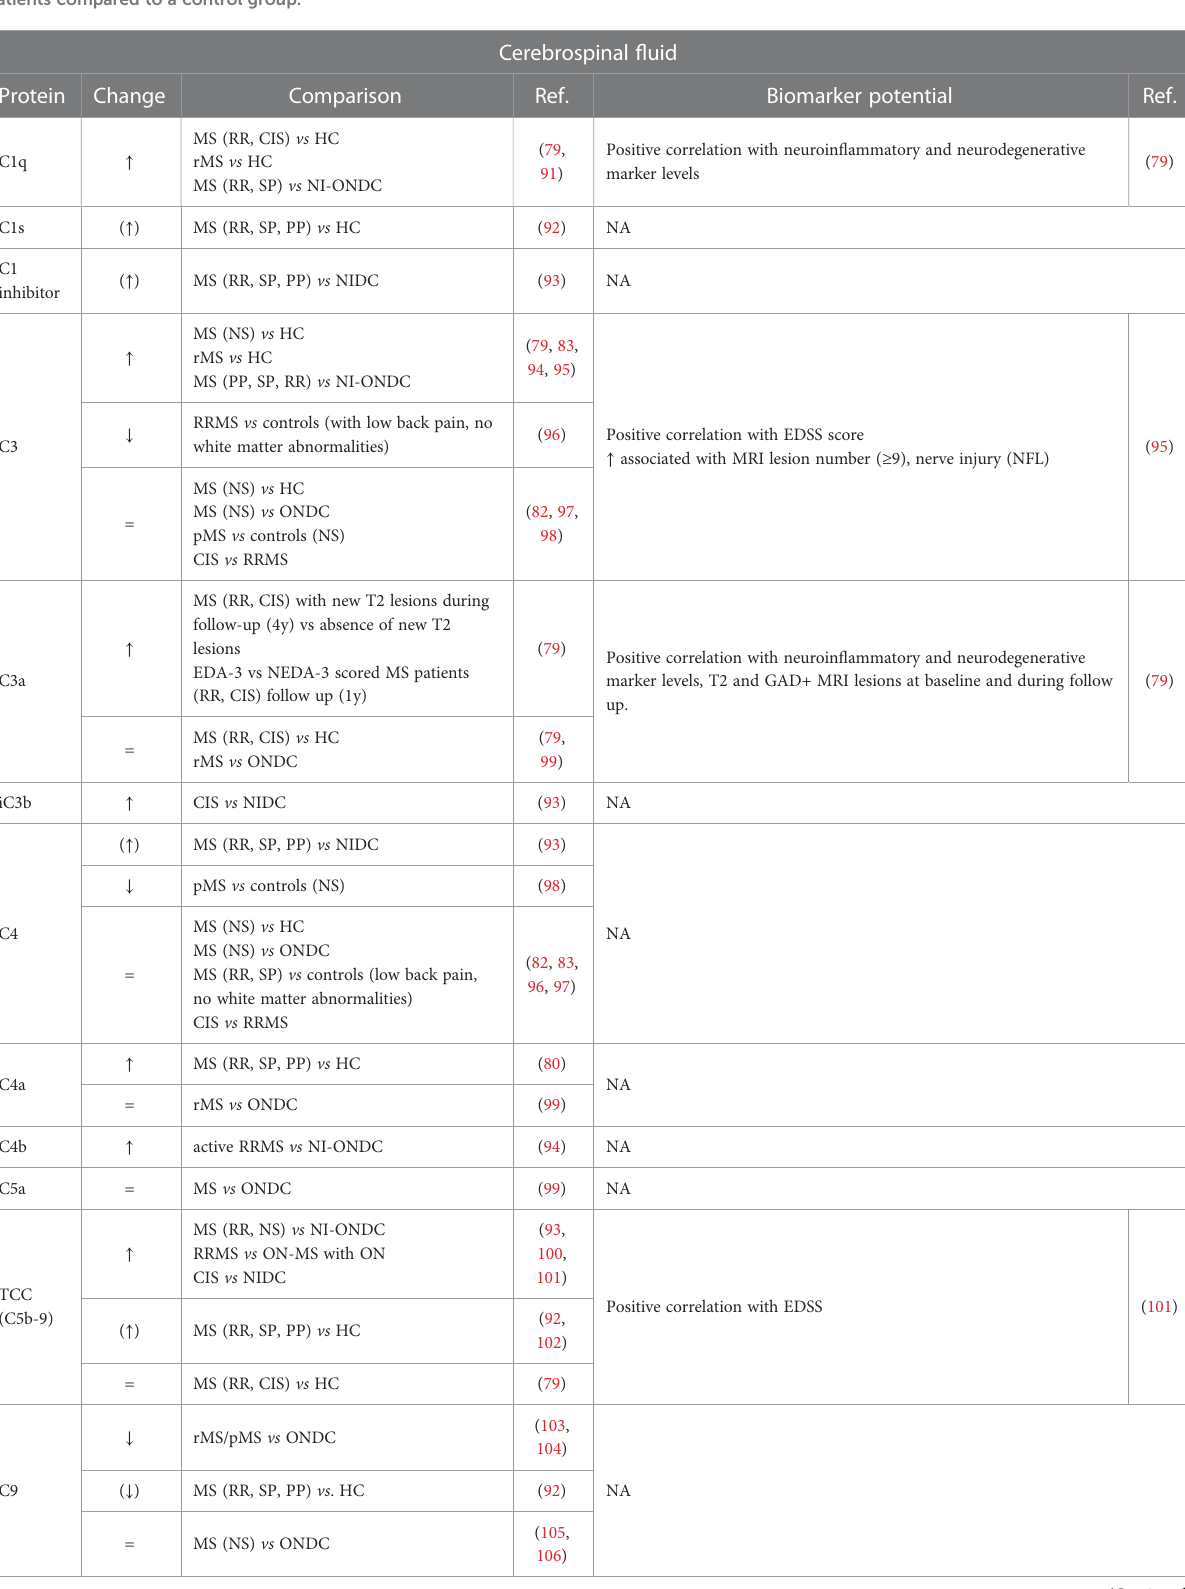
TABLE 3 Overview and biomarker potential of complement components evaluated in the cerebrospinal fl uid (CSF) of multiple sclerosis (MS) patients compared to a control group.